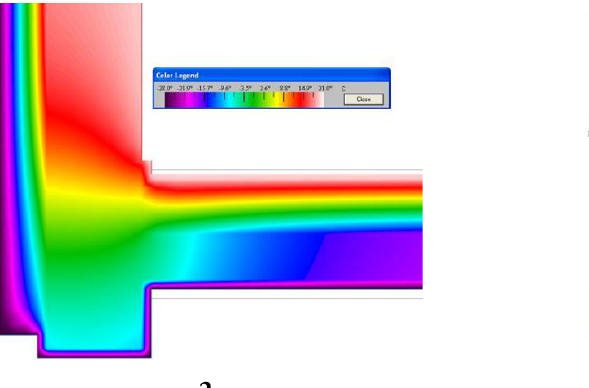
c Figure 10. Thermal insulation of the cottage: ( a ) unrolling the roll of polyethylene foam; ( b ) fixing the insulation on the outer contour of the building and stitching the roll of polyethylene foam; ( c ) the insulating shell and window openings . Secondly, these are framed and frameless technical structures: insulation systems for warehouses, parking lots, and livestock facilities (Figure 11). In this case, the insulation shell is formed along the internal contour of the structure. Structures of this type provide protection from atmospheric influences as well as operational safety of equipment, ma- chinery, and so on. When insulating agricultural facilities, the priority is to maintain the internal microclimate. As already mentioned, effective solutions are also achieved in the systems of insulation of surfaces in contact with the ground.